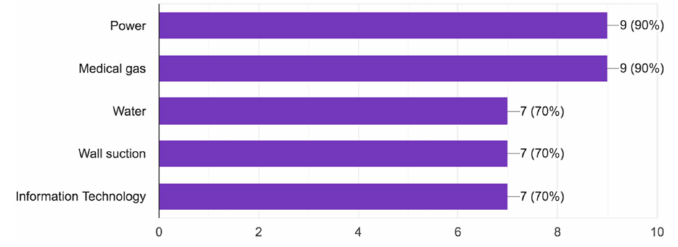
Figure 1. Neonatal intensive care units (NICU) redundant systems.